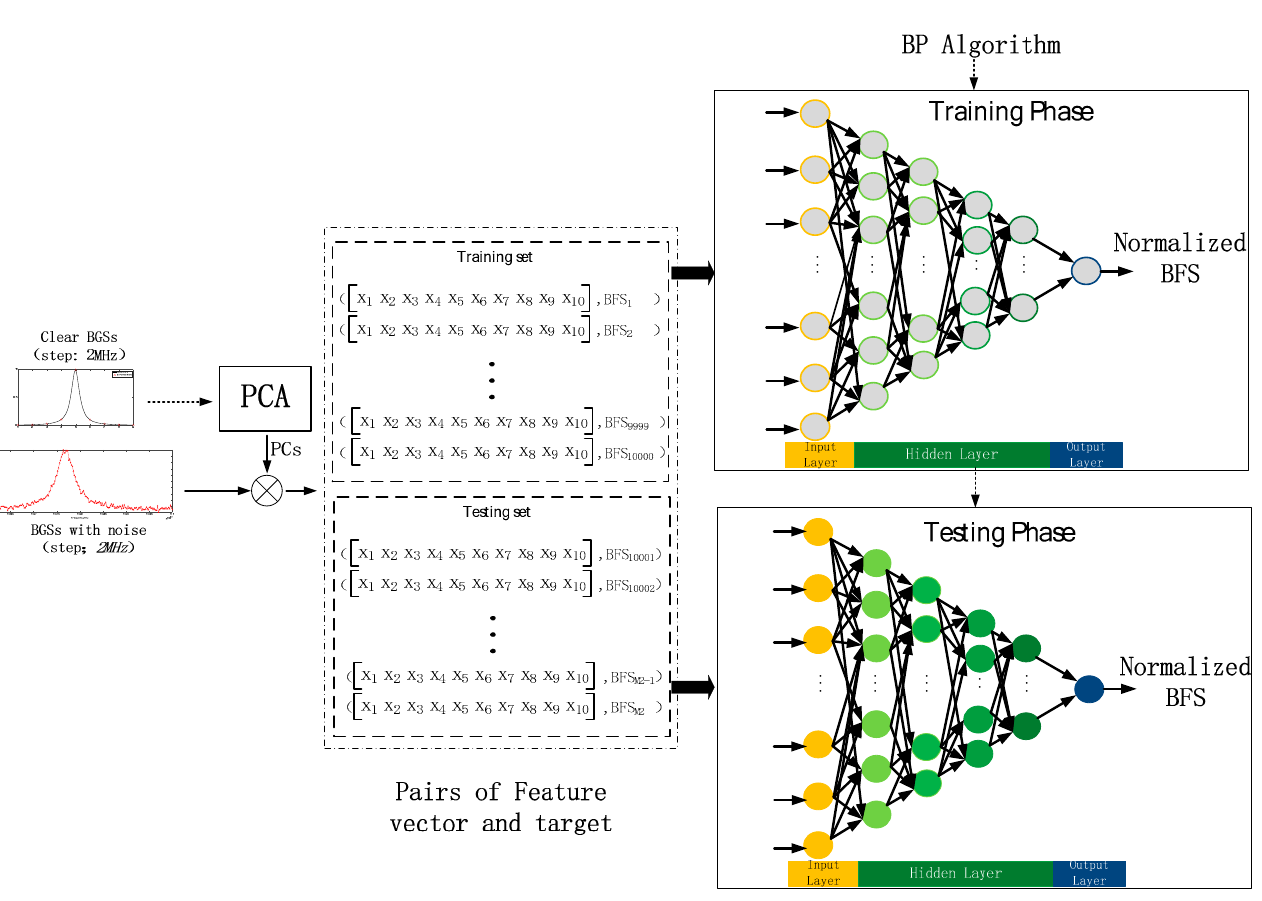
Figure 3. Detailed architecture for the measurement of BFS using the proposed method. The matrix, PCs, is obtained from a group of clear BGS, and another group of BGS, as input data, is divided into two parts: a training set to train the FNN, and a testing set to determine the generalization ability of the FNN. The layout of the FNN is set to 10-50-15-1. The output of the FNN is normalized BFS.